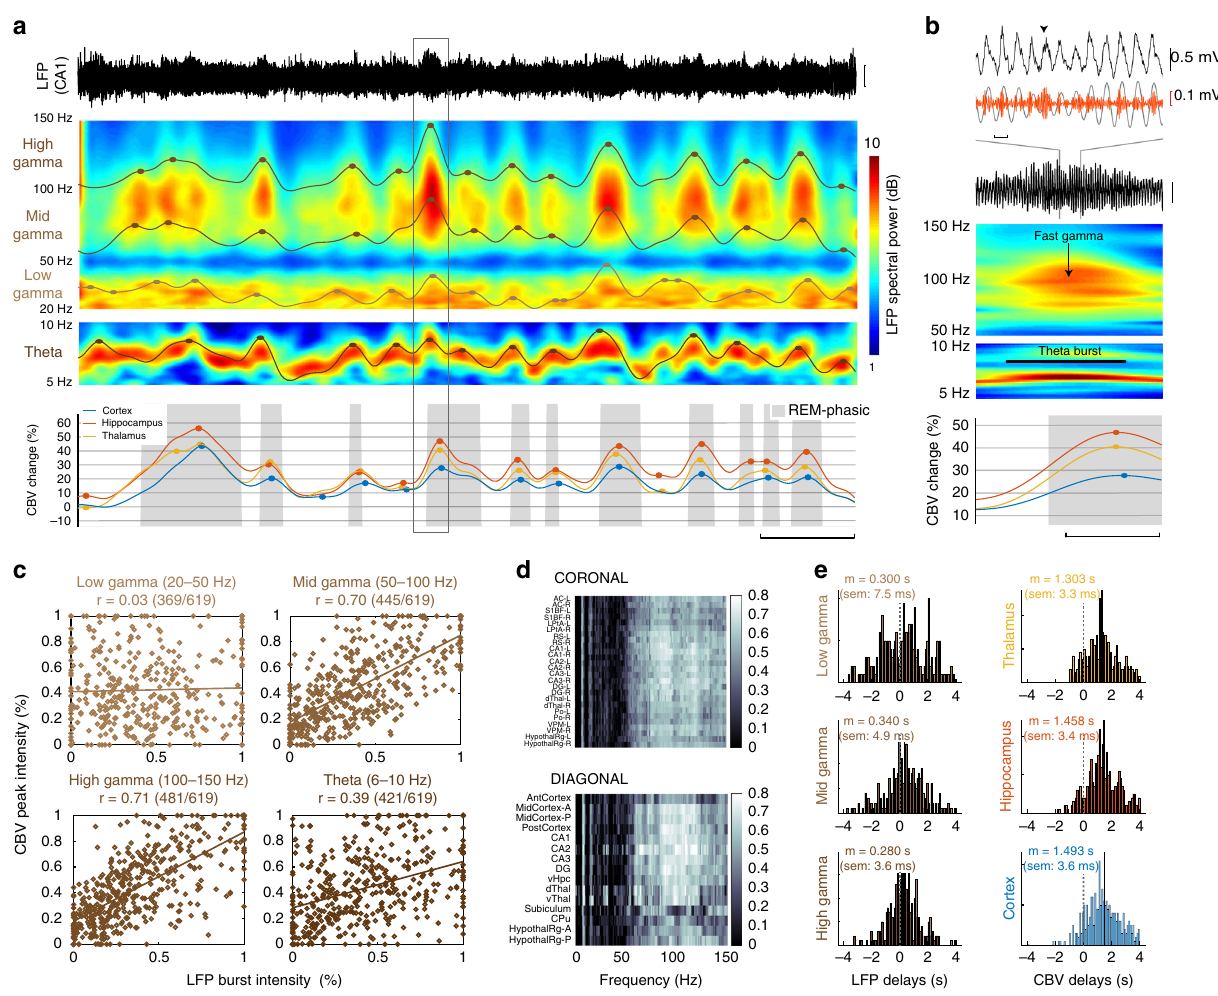
Fig. 3 Hippocampal theta and fast gamma bursts precede vascular surges. a CA1 Hippocampal LFP trace (top) time-frequency spectrograms with four LFP envelopes (middle) and regional CBV dynamics (bottom) for a typical REM sleep episode. Solid circles mark the regional peaks for LFP and CBV signals. Note that each vascular surge (gray box) is preceded by sustained activity in the theta, mid-gamma, and high-gamma bands. Note that we can pair up LFP peaks (brown/black dots) with corresponding vascular peaks (color dots) to investigate LFP-CBV coupling. Scale bar: 30 s. b Typical LFP precursor to a vascular surge (extended box shown in a ). At the onset of the VS, CA1 hippocampal LFP shows prominent theta and fast gamma bursts, occurring on the ascending phase/peak of the theta cycle (gray curve). Upper scale bar: 100 ms. Lower scale bar: 5 s. c Scatter plot showing the correspondence between LFP peaks ( x- axis) corresponding CBV peak ( y- axis), for the four frequency bands shown in a . Note the strong correlations in the mid (50 – 100 Hz) and high (100 – 150 Hz) gamma bands, showing that hippocampal gamma predicts the amplitude of vascular ampli fi cation. The numbers in bracket specify the pairing ratio between LFP and CBV peaks. d Exhaustive analysis of LFP-CBV correlations for all brain regions and LFP frequency bands. Horizontal axis: LFP bands, Vertical axis: regional CBV variables. Each coef fi cient of matrices is obtained by generalizing the approach in c . Note that highest correlations are obtained for gamma-mid band (50 – 100 Hz) in the hippocampal (DG-CA1-CA3) and dorsal thalamic (dThal) regions. e Histograms of delays for the three LFP gamma sub-bands and the three CBV regions, relative to theta peaks. Note that cortical delays ( m = 1.493 s) are longer than thalamic ( m = 1.303 s) and hippocampal ( m = 1.458 s)